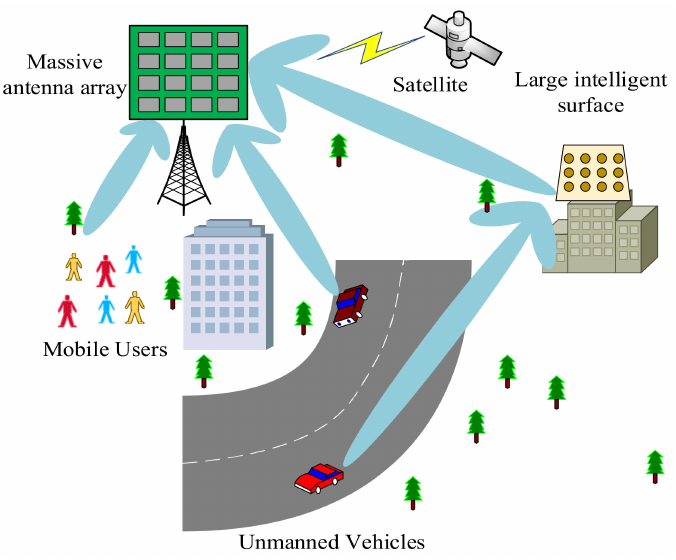
Figure 1. Illustration of beamforming in B5G/6G wireless communication